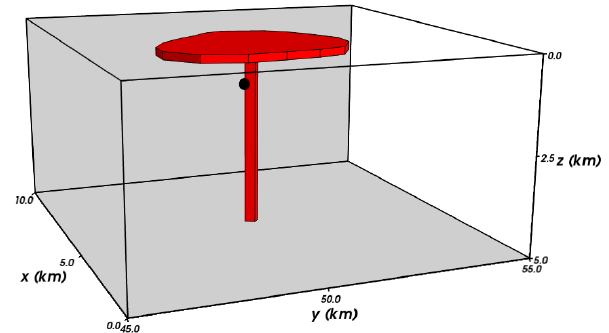
Figure 12. Igneous intrusion. 3-D view of the intrusion (red prisms) and the estimate of the intrusion position by using Euler deconvolu- tion (black point) with a structural index equal to 3. Notice that the Euler solution falls outside the intrusion.